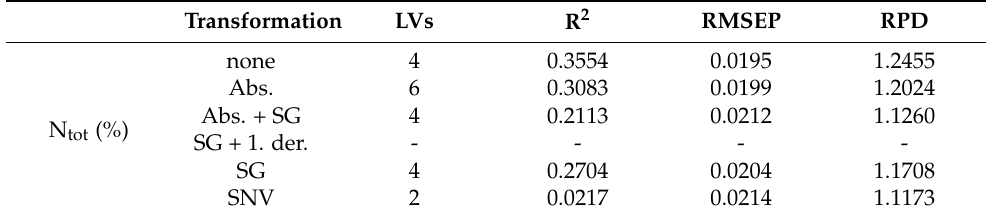
Table 4. Evaluation of developed models for original data collected with the spectrometer.